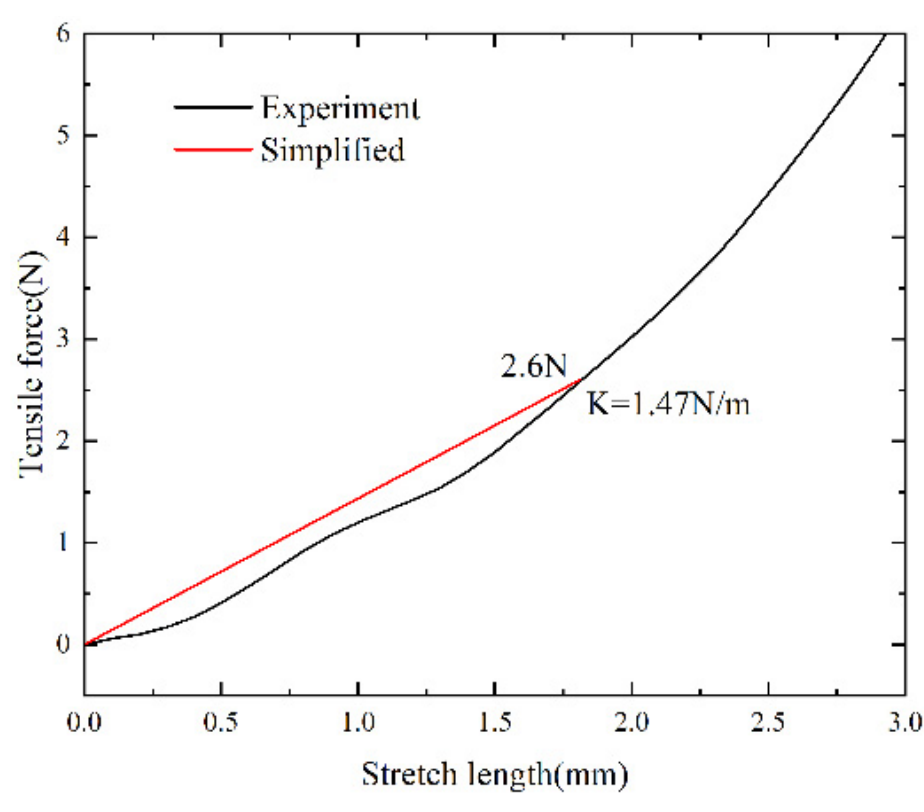
Figure 9. Result of stiffness selection.